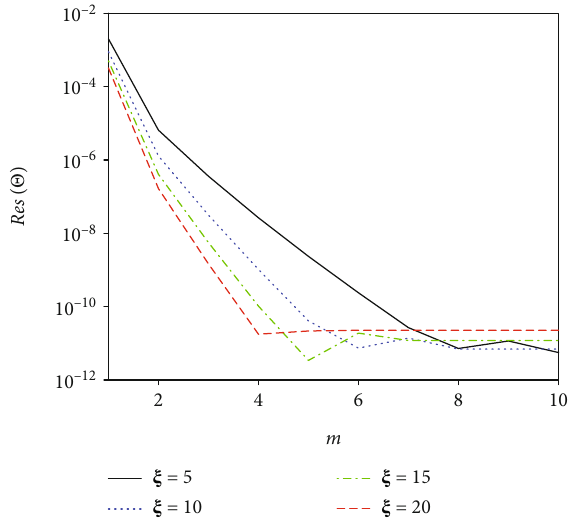
Figure 21: Variation of residual error Res ð F Þ against increasing order ð m Þ of LSPM series approximation for di ff erent values the non-similar parameter ξ , when n = 0 : 5, K = 0 : 5, Pr = 10, S = 3, N